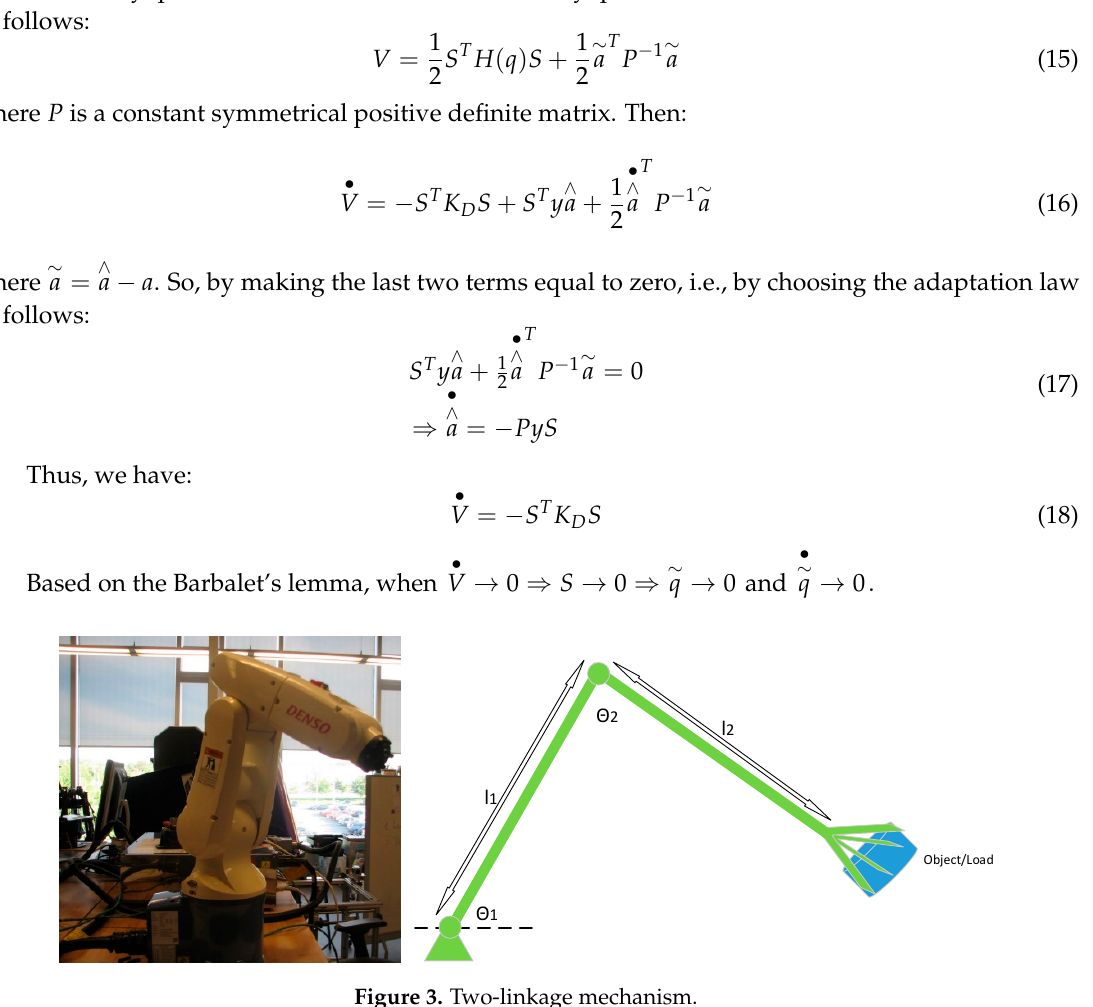
Figure 3. Two-linkage mechanism.